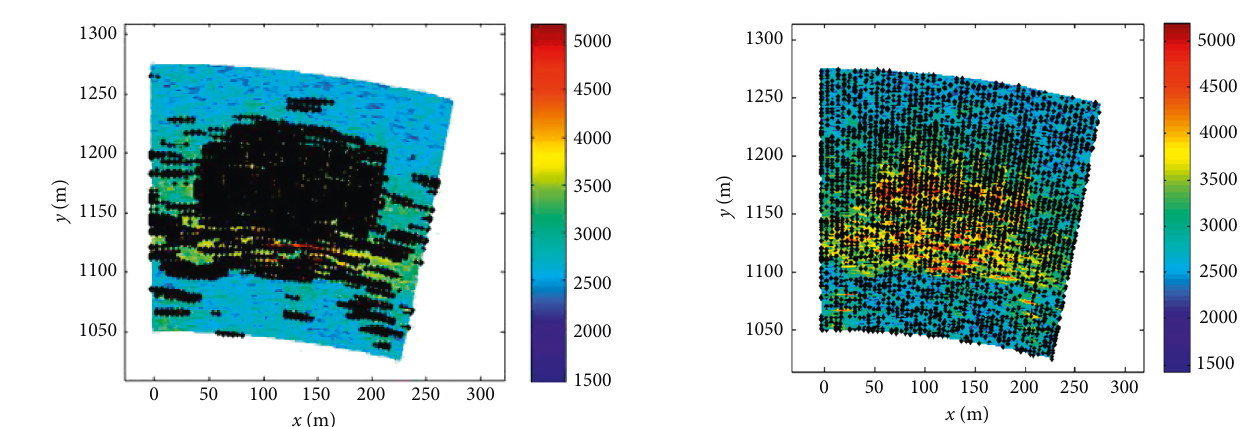
D method (the black dots